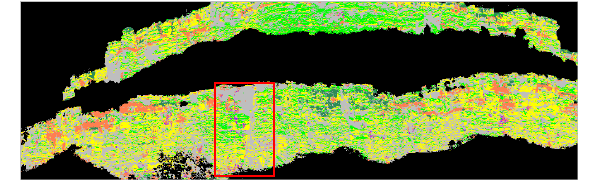
Figure 2. Classification of Garley Canyon outcrop (Light green: siltstone; yellow: sandstone; orange: carbonate; dark green: weathering; purple: gypsum; grey: unclassified; black: masked). Rectangle shows location of Fig. 4.